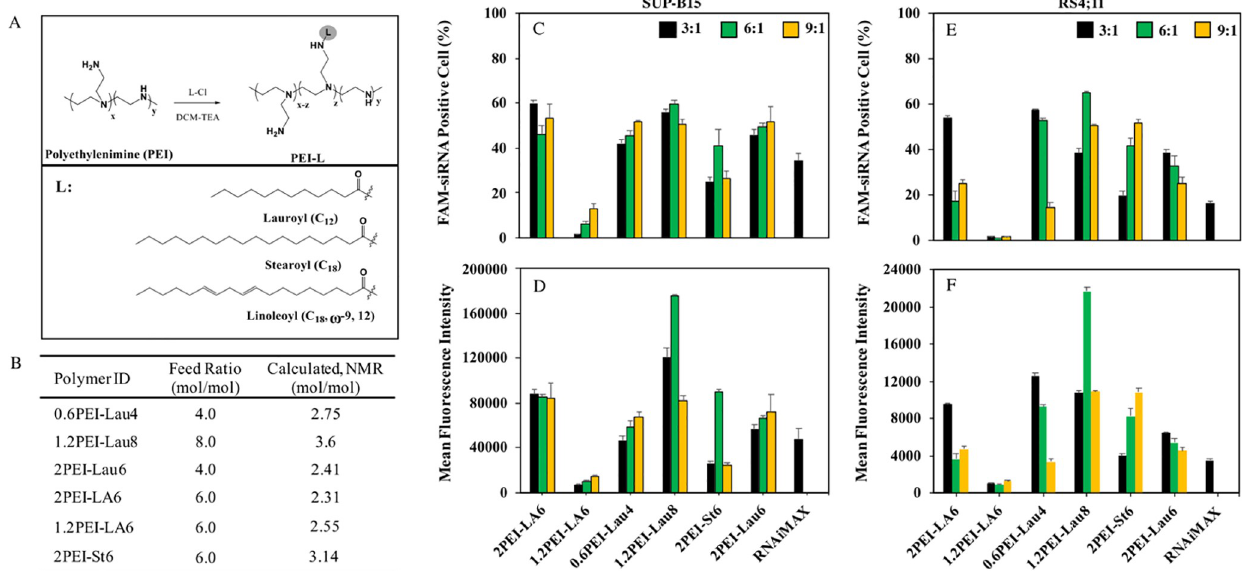
Fig 1. Schematic illustration of the synthesis of lipid-substituted PEIs (A). The obtained lipid substitutions as a function of lipid:polymer feed ratio during synthesis (B). (C-E) The uptake of FAM-labelled siRNA at 30 nM with polymer:siRNA ratios of 3:1, 6:1 and 9:1 after 24 hours of treatment. The percentage of cells that have taken up the siRNA are shown as FAM-positive SUP-B15 cells and RS4;11 cells (C and E, respectively) (n = 3). The mean fluorescence intensity in SUP-B15 and RS4;11 cells are also shown (D and F, respectively) (n = 3). Lipofectamine RNAiMAX was used as a reference delivery reagent at polymer:siRNA ratio of 2.5:1. FAM-siRNA positive cells and mean fluorescence were determined by flowcytometry.